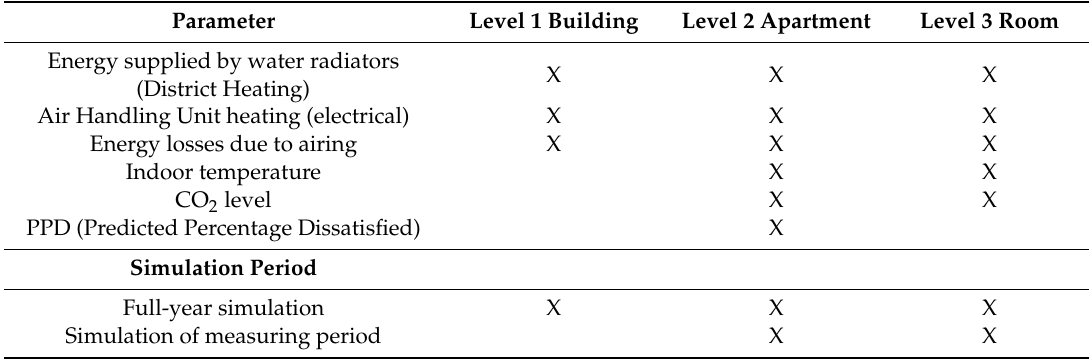
Table 9. This table describes which parameters were compared between reference BES (BES-ref) and BES version 2 (BES-v.2) at each